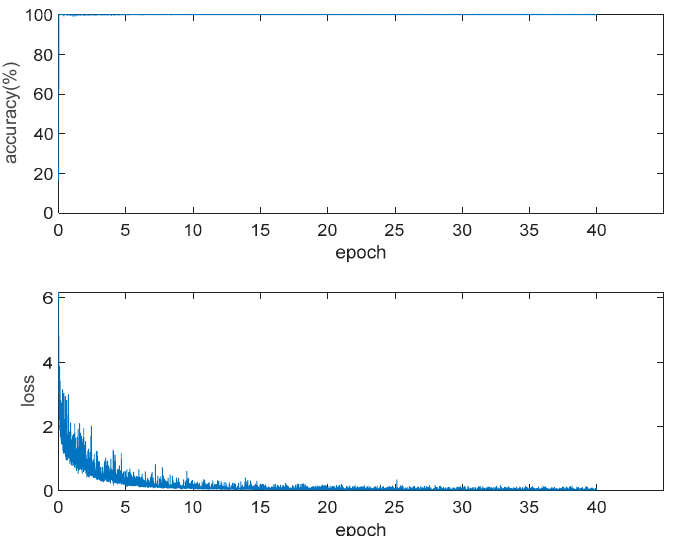
Figure 5. Loss and accuracy in Faster RCNN training.